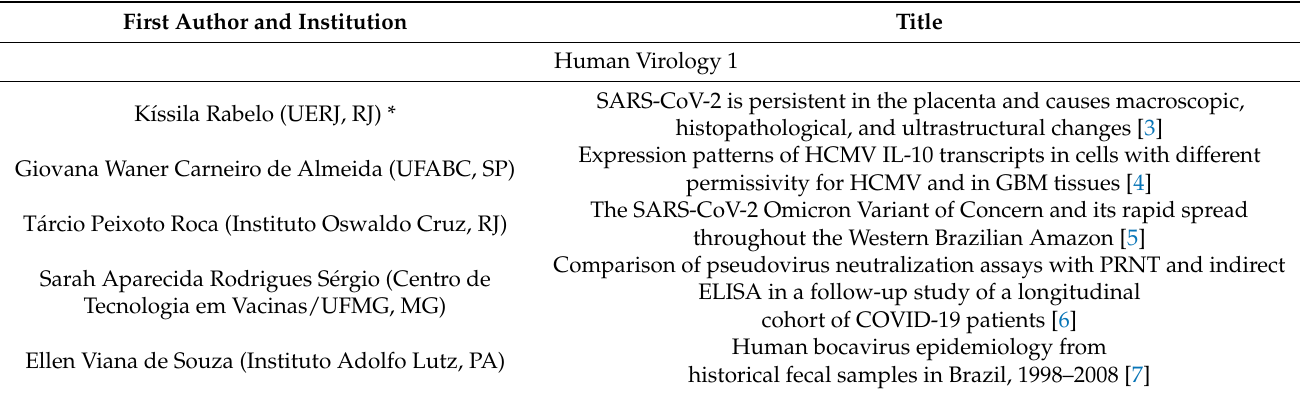
Table 2. Oral presentations at the 33rd Brazilian Society for Virology